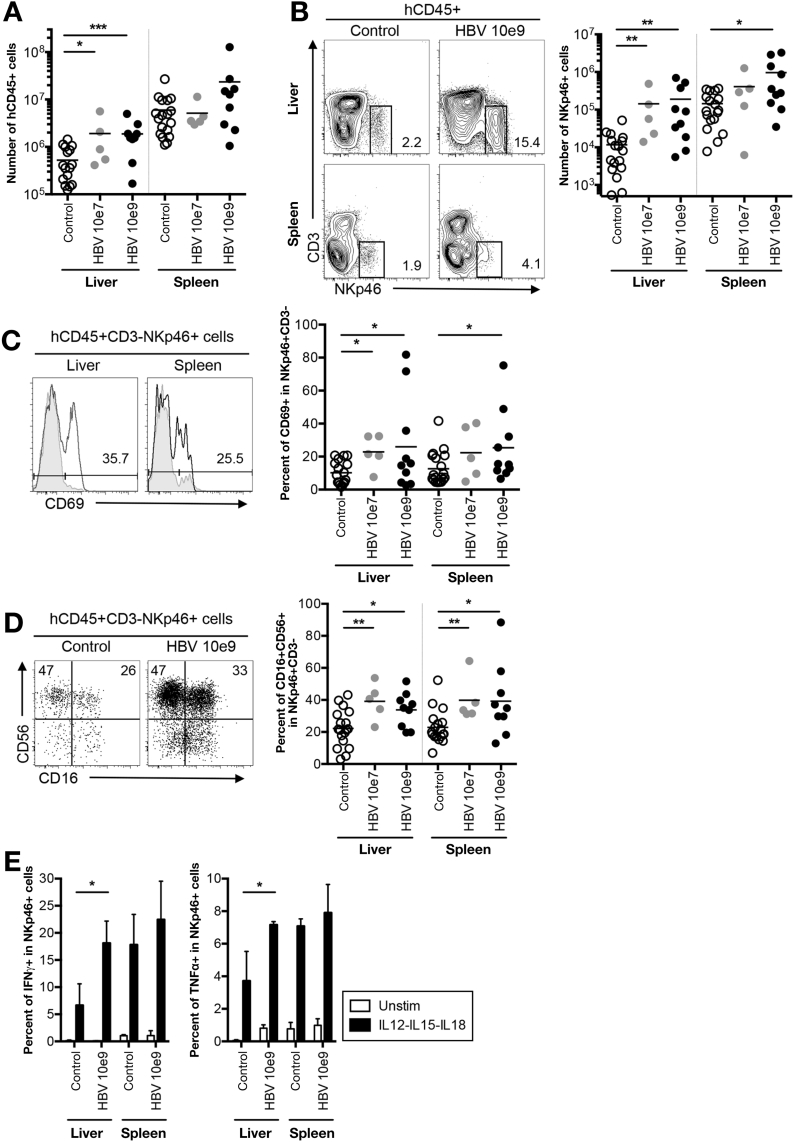
NK-cell mediated immune response in HBV-infected HIS-HUHEP mice. (A) Absolute numbers of total human leukocytes (hCD45+) and (B) NK cells (CD3-NKp46+) from the liver and spleen of control and HBV-infected mice. Representative FACS plots show the percent positive cells in each gate. (C) Frequency of CD69+ cells among NK cells in the liver and spleen from control (grey filled line) and HBV-infected (black open line) HIS-HUHEP mice. The percentage of positive cells from HBV-infected mice is shown. (D) Expression of CD56 and CD16 in NK cells from the liver of control or HBV-infected HIS-HUHEP mice. (E) Liver leukocytes or splenocytes were restimulated ex vivo overnight and analyzed by FACS for the expression of IFN-γ or TNF-α by NK cells. Histograms show the mean and SEM. In plots each dot represents a mouse, data obtained at 14–20 wpi. Statistical analysis in A–D: Mann Whitney U test, E: 2 way ANOVA.